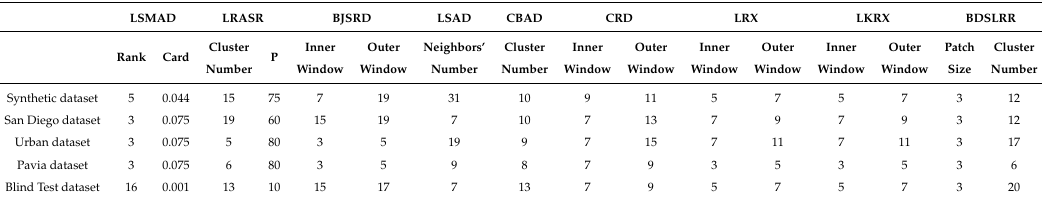
Table 6. Optimal Parameters of All Methods for All